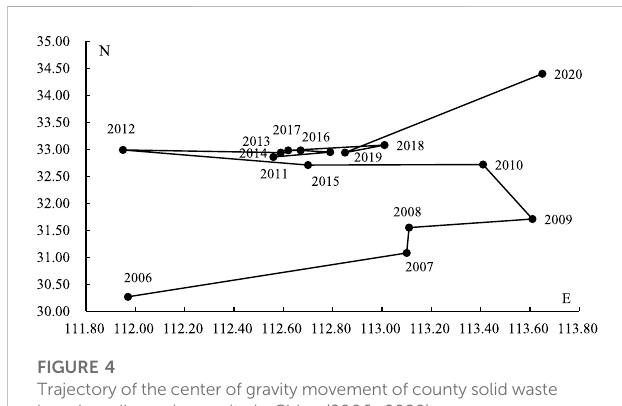
FIGURE 4 Trajectory of the center of gravity movement of county solid waste harmless disposal capacity in China (2006 –